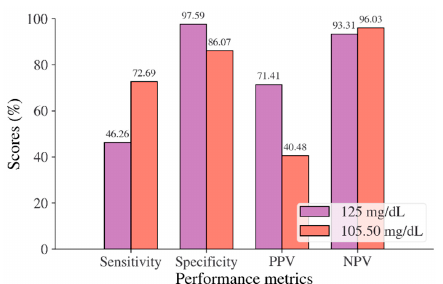
Figure 6. Sensitivity, specificity, PPV, and NPV for FBS in the Korean adult population based on ADA and WHO cut point recommendations compared to the optimal cut point.